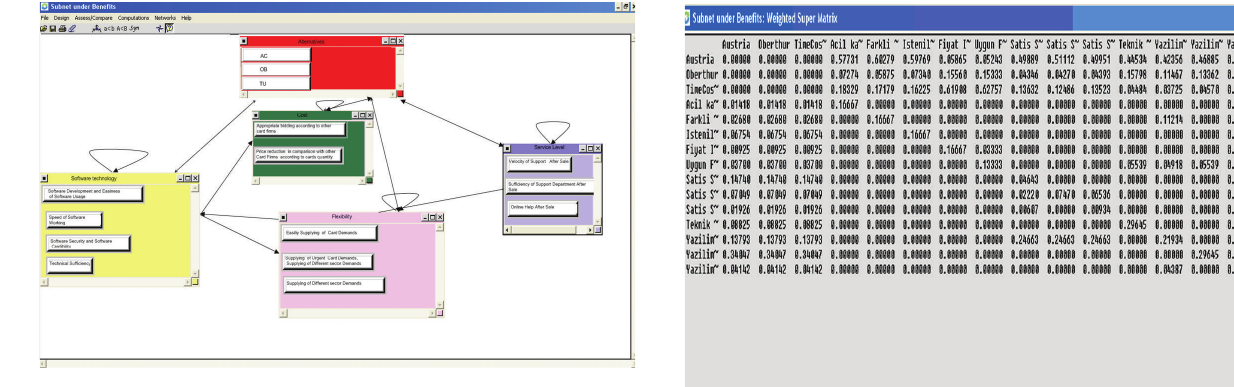
Figure 7: Network structure of the ANP e-purse smart card tech- nology selection model.